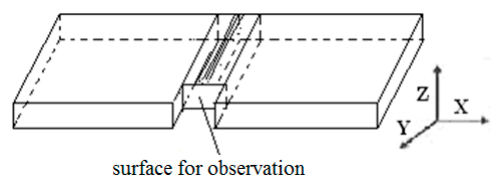
Figure 4. Diagrammatic sketch of the position for microscope and microhardness.